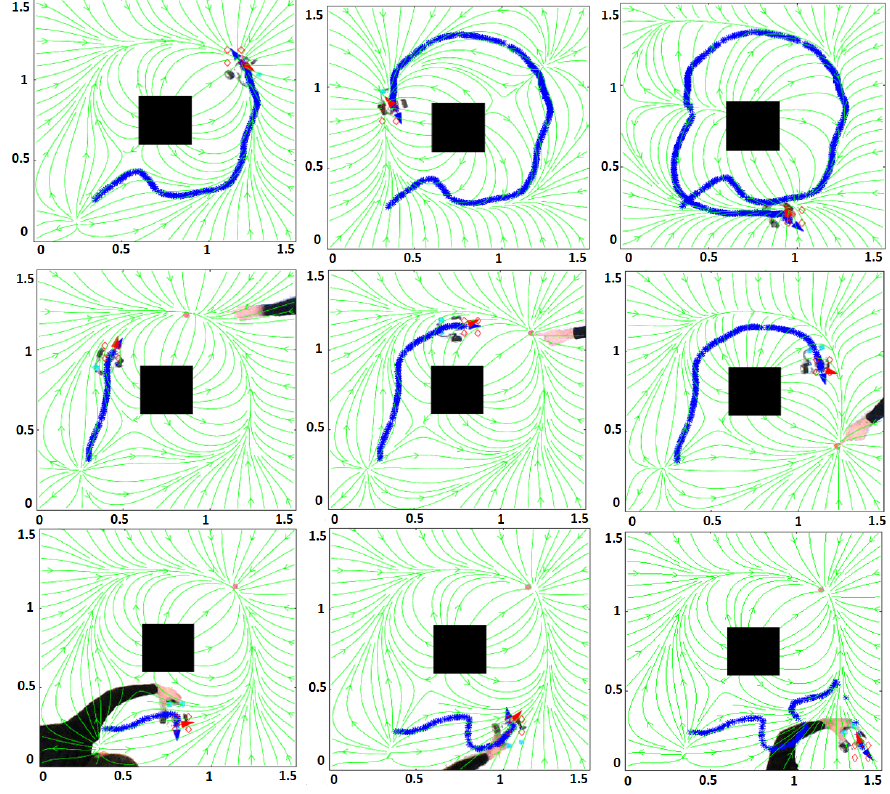
Figure 7. Experimental tests with a LEGO robot. Rows 1, 2, 3 for tests 1B, 2B,